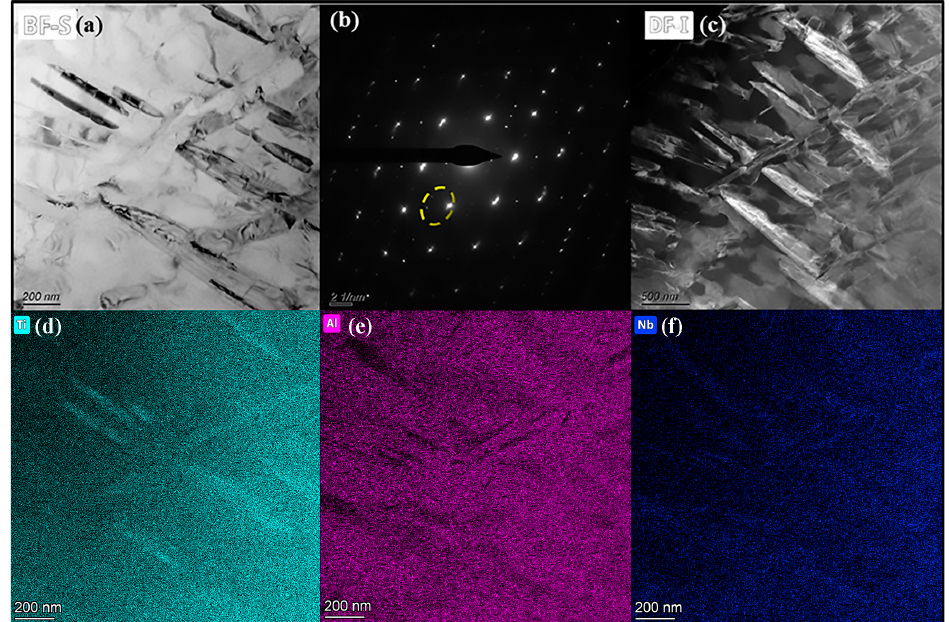
Figure 14. ( a ) TEM image of S4 (scanning speed: 900 mm/s). ( b ) SAED pattern corresponding to ( a ). ( c ) Dark-field image recorded using the reflections in the yellow circle in ( b ). ( d – f ) HAADF mapping images of Ti, Al, and Nb.